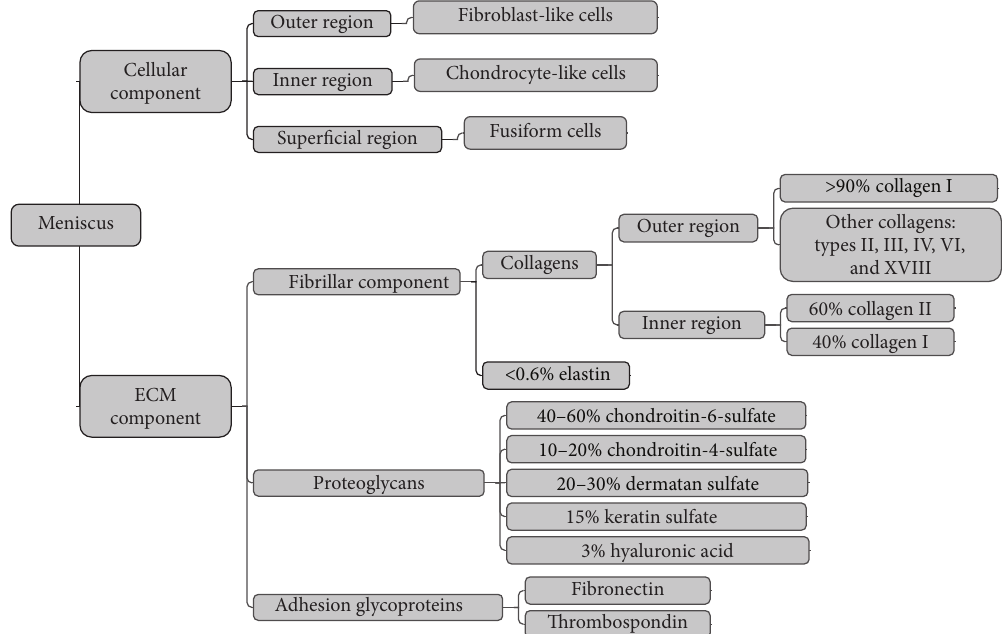
Figure 2: The complex composition of the meniscal cellular and meniscal extracellular matrix (ECM) components. The outer region is the outer one-third of the meniscus; the inner region is the inner two-thirds of the meniscus; the superficial region is the surface of the meniscus.